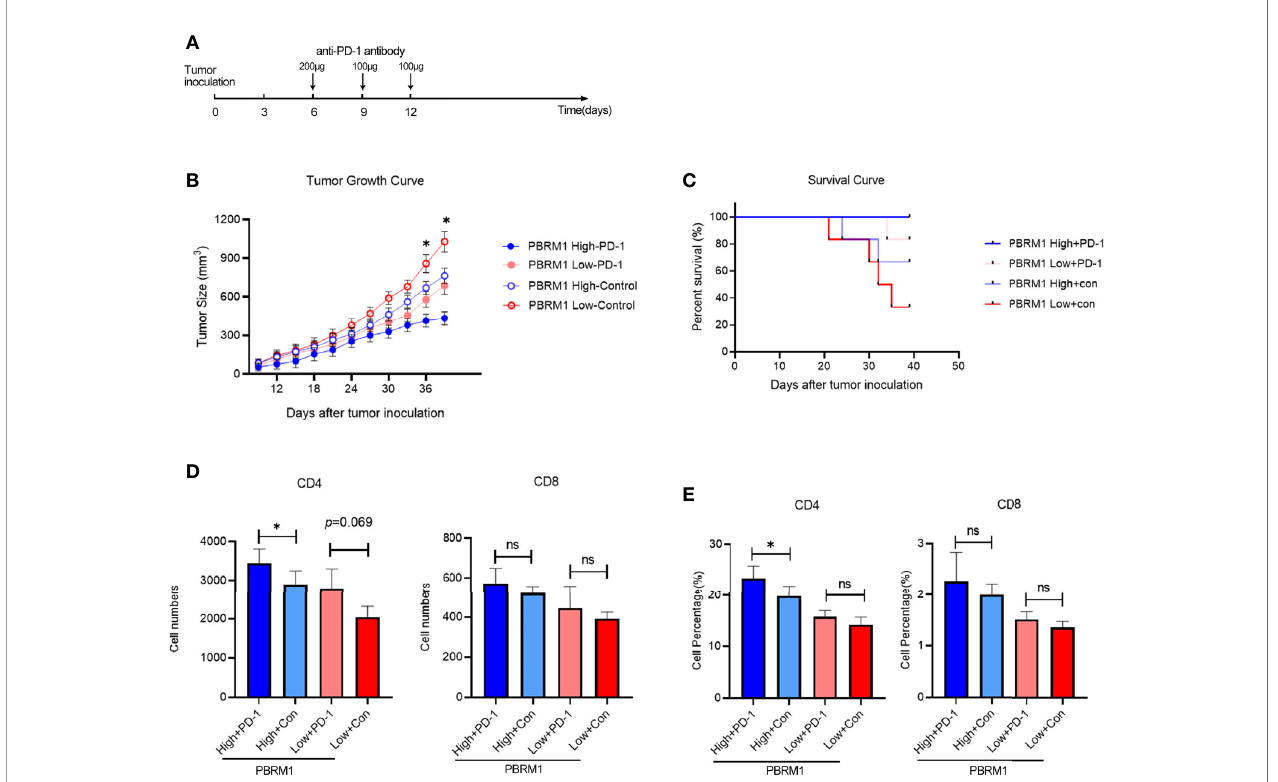
FIGURE 6 | Anti-PD-1 immunotherapy increased CD4 T cell in fi ltration in ccRCC mouse model. (A) Treatment scheme of anti-PD-1 immunotherapy in ccRCC mouse model. Anti-PD-1 antibody and control antibody were administrated at day 6, day 9, and day 12 after tumor inoculation. (B) Growth curves of PBRM1 High and PBRM1 Low tumors treated with anti-PD-1 antibody or control isotype antibody in ccRCC mouse model. Test was stopped when mice died or tumors reached 1000mm 3 in size. (C) Survival rates of mice in different groups. Data were analyzed with GraphPad Prism 8.0.2. Absolute cell numbers (D) and percentages (E) of CD4 and CD8 T cells in tumors of different groups were shown. All live mice were euthanized at day39 and tumor in fi ltrating T cells were detected by Flow Cytometry. Data are presented as mean ± SD with at least 6 mice for each group. *p < 0.05; ns, no signi fi